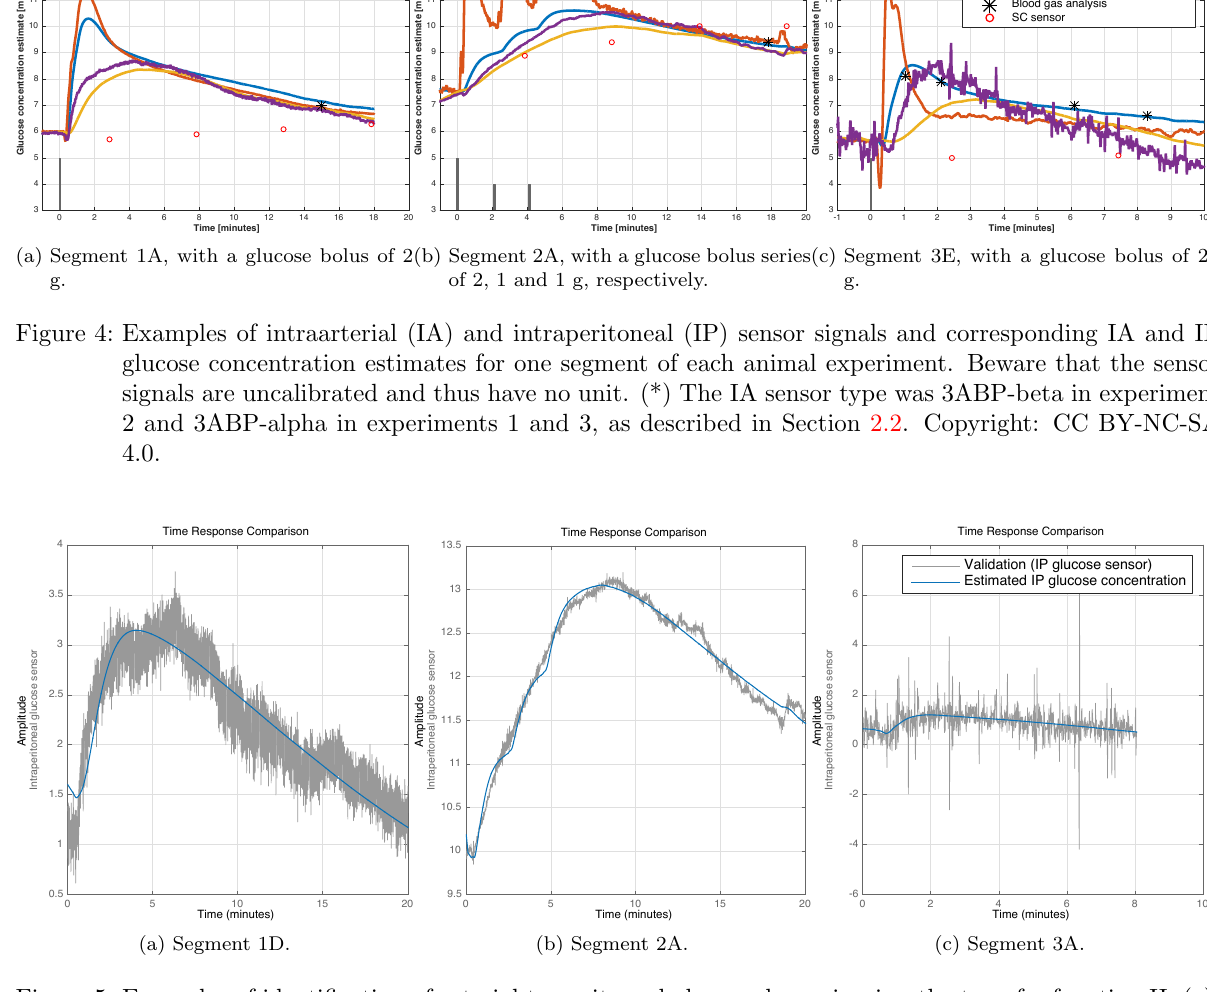
Figure 5: Examples of identification of arterial to peritoneal glucose dynamics, i.e. the transfer function H P ( s ), for one segment of each animal experiment. The grey signal represents the IP sensor signal, while the blue signal shows the IA sensor signal transferred through H P ( s ). Beware of the scaling of the vertical axes, and that they have no unit, since the signals are uncalibrated. The seemingly variable signal-to-noise ratio is mostly due to the scaling. Copyright: CC BY-NC-SA 4.0. Combining Eqs. 1 and 2 gives Eq.